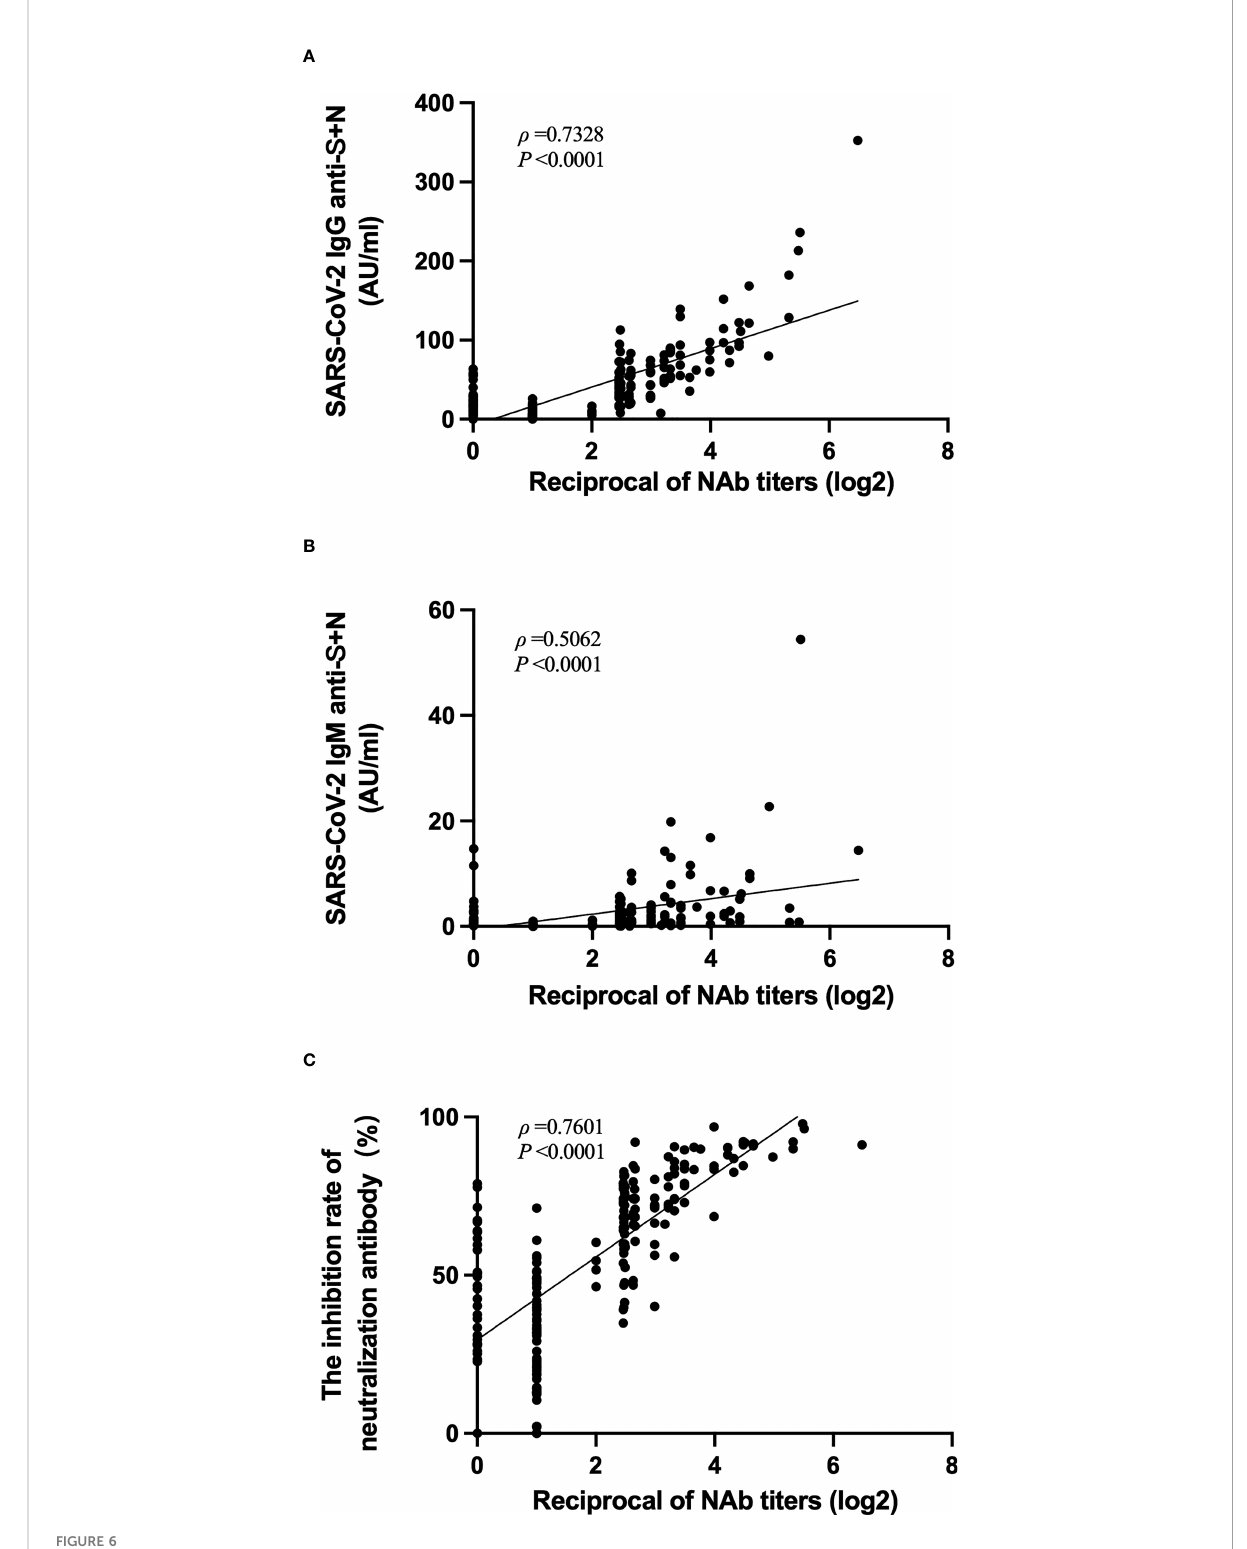
FIGURE 6 Correlation among levels of anti-SARS-CoV-2 IgG, IgM, inhibition rates of neutralizing antibodies to pseudovirus, with levels of neutralizing antibodies to live SARS-CoV-2. (A – C) Correlation of anti-SARS-CoV-2 IgG levels (A) , anti-SARS-CoV-2 IgM levels (B) , or inhibition rates of neutralizing antibodies to pseudovirus (C) with the levels of neutralizing antibodies to live